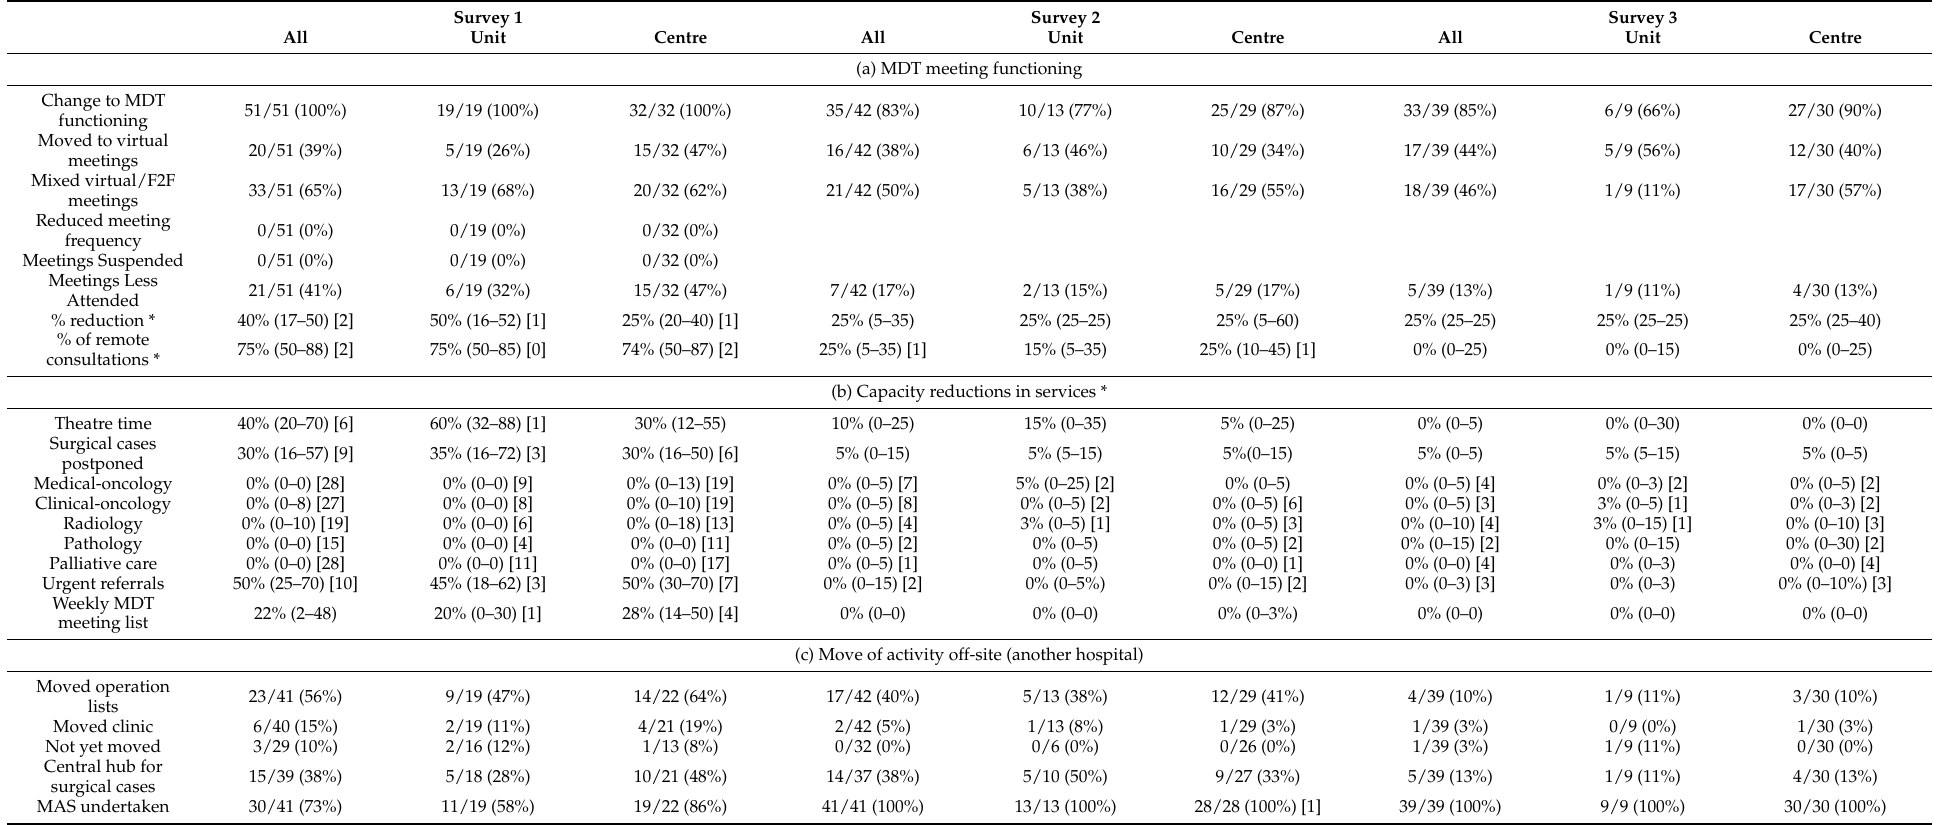
Table 2. Structural changes and workload across